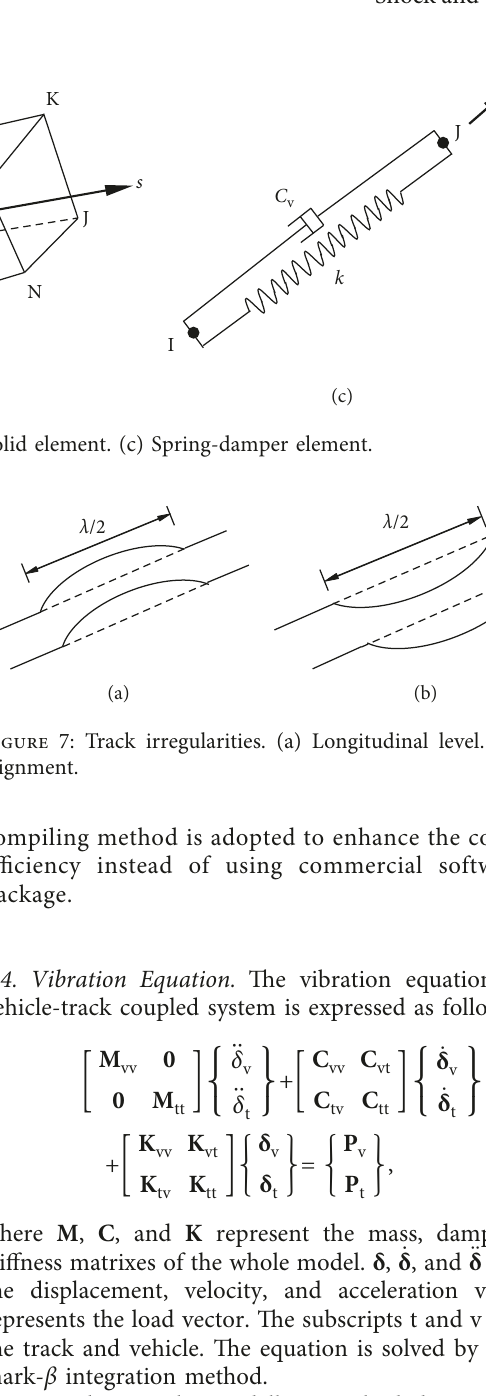
Figure 6: Equivalent conicity.